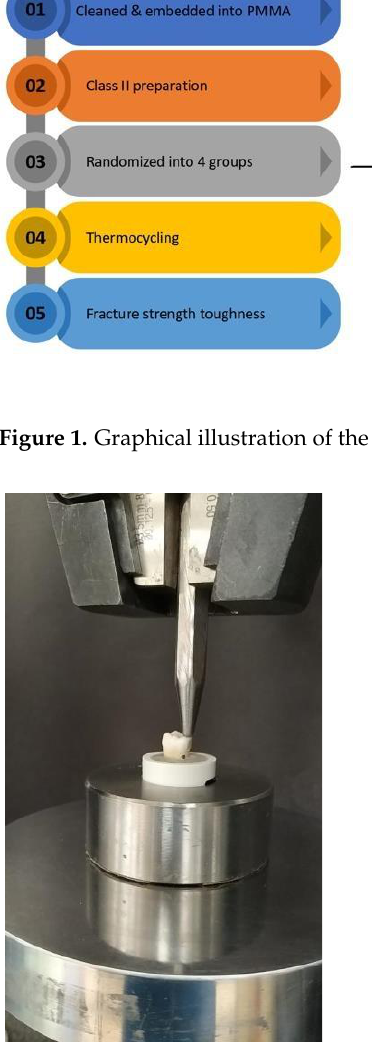
Figure 1. Graphical illustration of the study design .